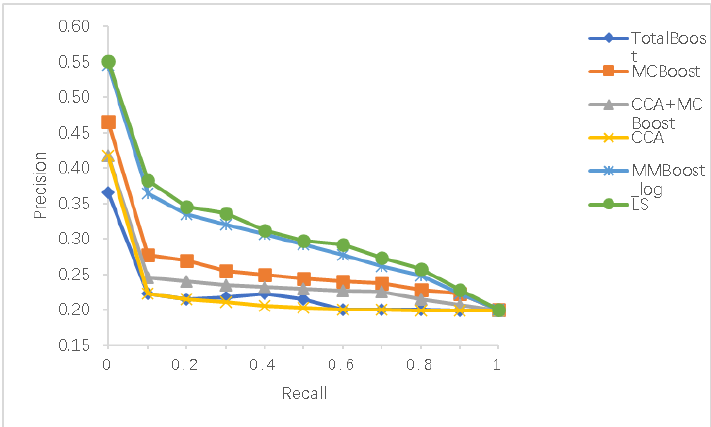
Figure 8. Precision–recall curves for text retrieval images.